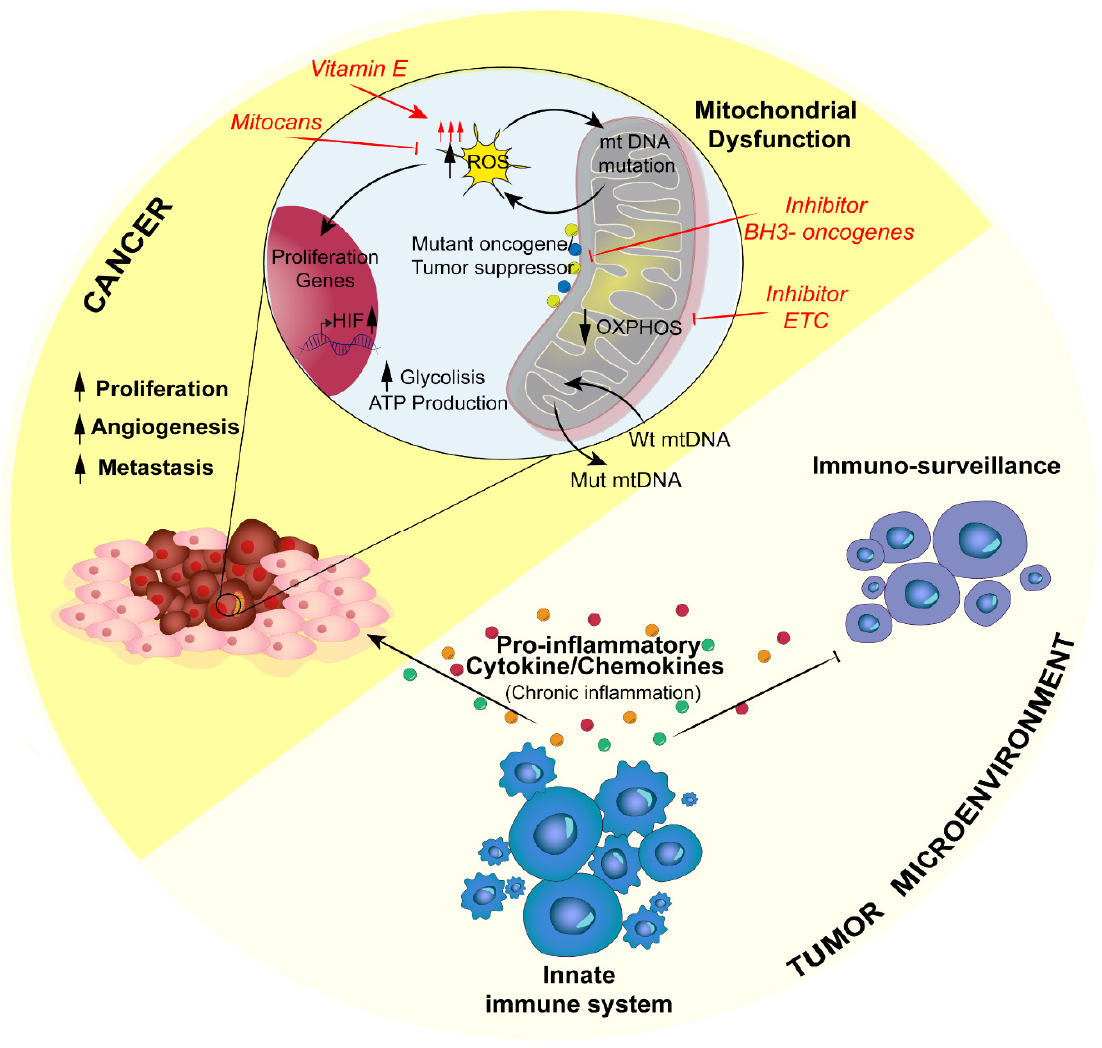
Figure 3. Schematic representation of how mitochondrial dysfunctions, which alter the inflammatory response, can promote cancer. In cancer, mitochondrial dysfunctions lead to increased ROS production, which can have a dual role that is either dangerous or prosurvival. On the one hand, mitochondrial ROS (mROS) can accumulate DNA mutations; on the other hand, mROS can increase cytokine inflammatory release from the innate immune system. A strategy that cancer cells can adopt to survive the increased rate of mutations is represented by the horizontal transfer of wild-type mtDNA molecules from surrounding healthy cells. The inflammatory response by the innate immune system can sustain cell tumor growth instead of counteracting it, altering the immune-surveillance and STING pathways (see text for further details). The main clinical strategy could be the selective inhibition of mROS production. ETC: electron transport chain; MOMP: mitochondrial outer membrane permeabilization; mtDNA: mitochondrial DNA; OXPHOS: